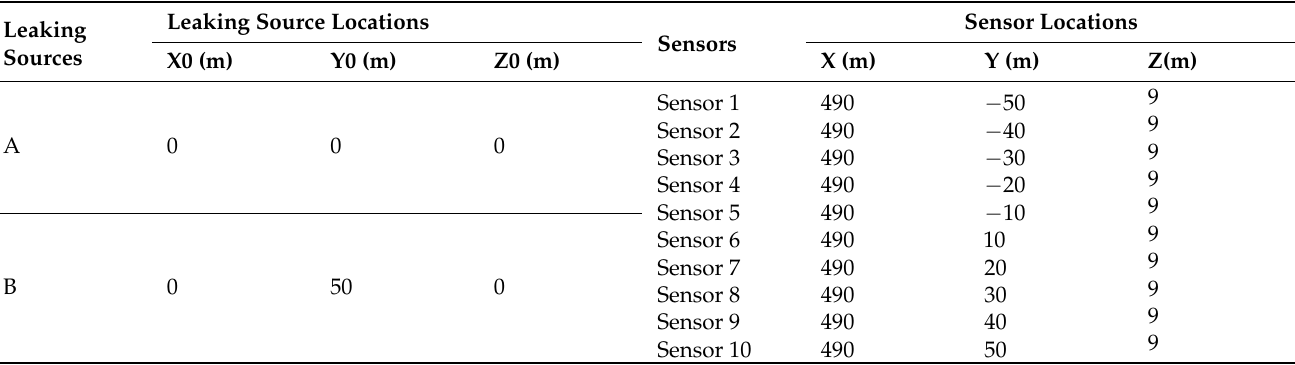
Table 1. Table 1. The location of hazardous-gas-leaking sources and monitoring sensors.